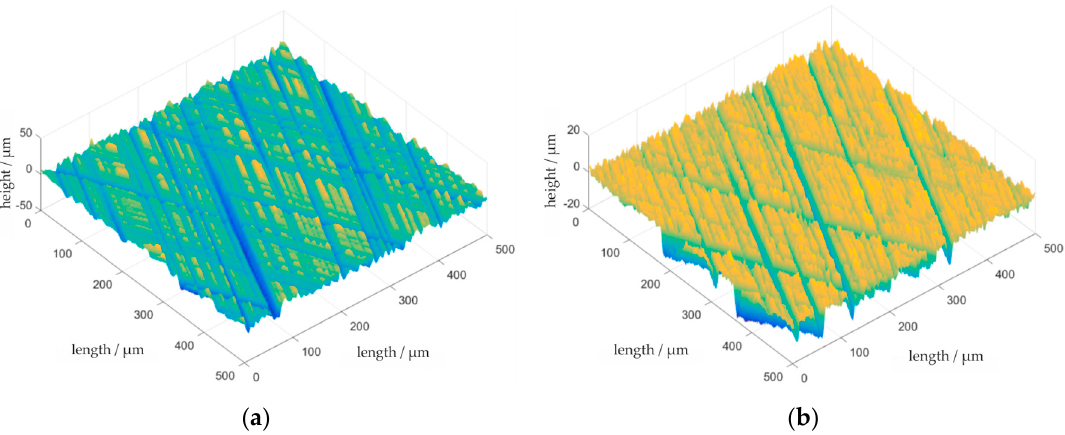
Figure 4. ( a ) Simulation of a one-step honed surface as the minimum of two simulated grinding surfaces. Parameters: As in Figure 3; ( b ) Simulation of a plateau honed surface ( Δ x = Δ y = 0.5 µm). Parameters step 1: l 1 = 500 µm; l 2 = 5 µm; ϕ = 25°; σ = 5.68 µm; µ = 3.2 µm. Parameters step 2: l 1 = 20 µm; l 2 = 2 µm; ϕ = 25°; σ = 1.8 µm; µ = 2.01 µm.